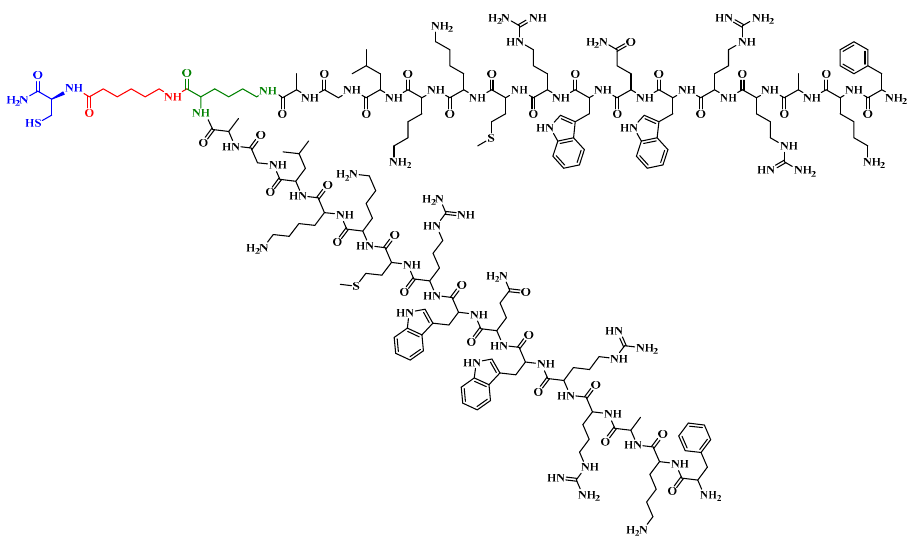
Figure 3. Structure of Polyvalent peptide ([ 19 Ala]-LfcinB 17–31) 2 . The structure contains lysine (in green), aminocaproic acid (in red) and cysteine (in blue) residues.